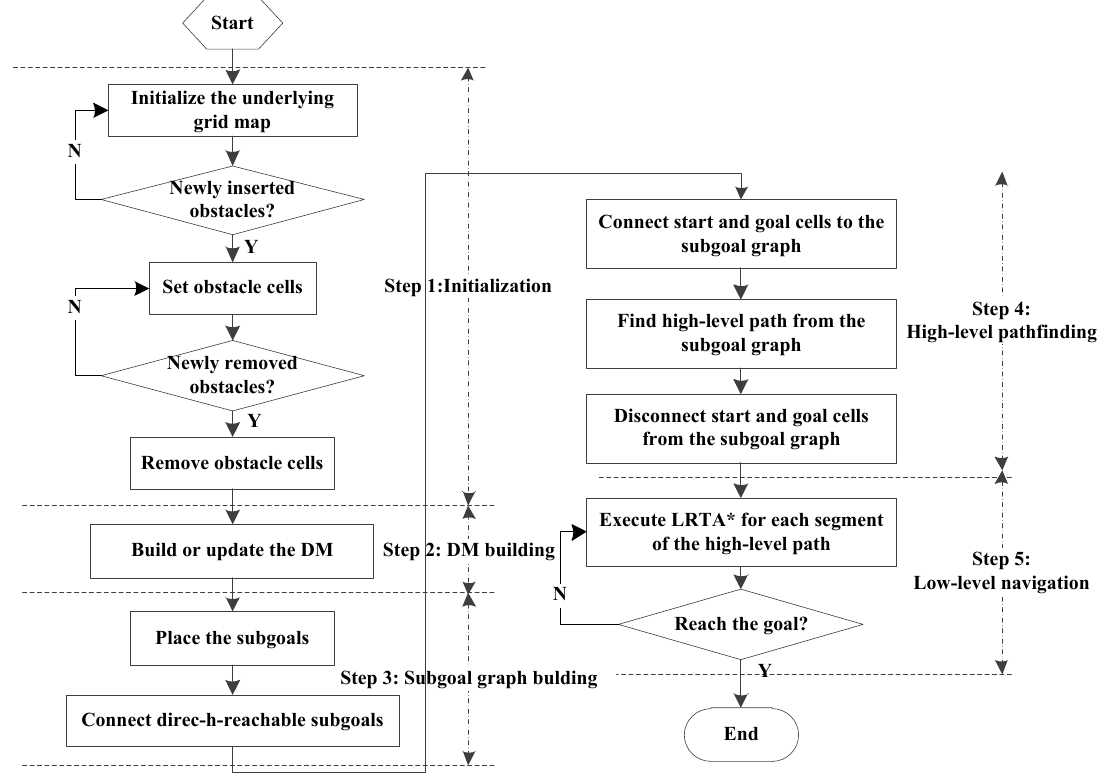
Figure 3. the flowchart describing the process of building a DM, building a DM-based subgoal graph, engaging a high-level path planning task, and executing Learning Real Time A* (LRTA*) to fulfill a low-level navigation